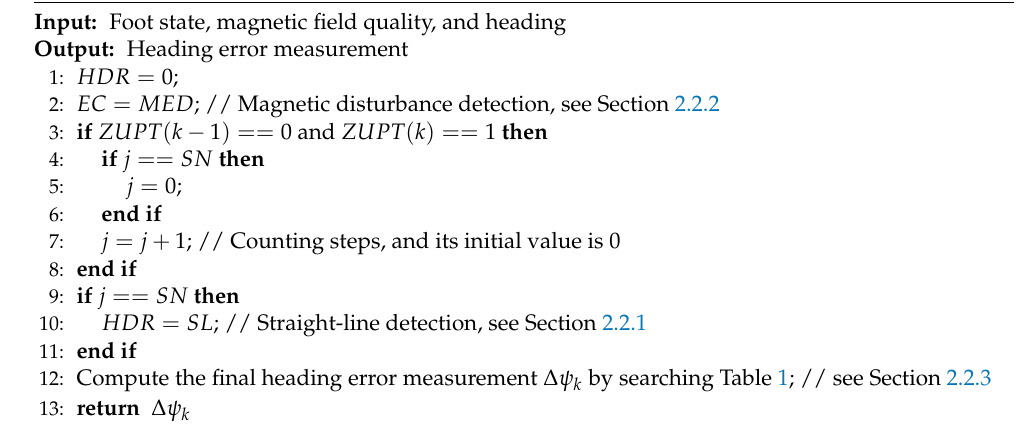
Algorithm 2 Operation of the adaptive fusion